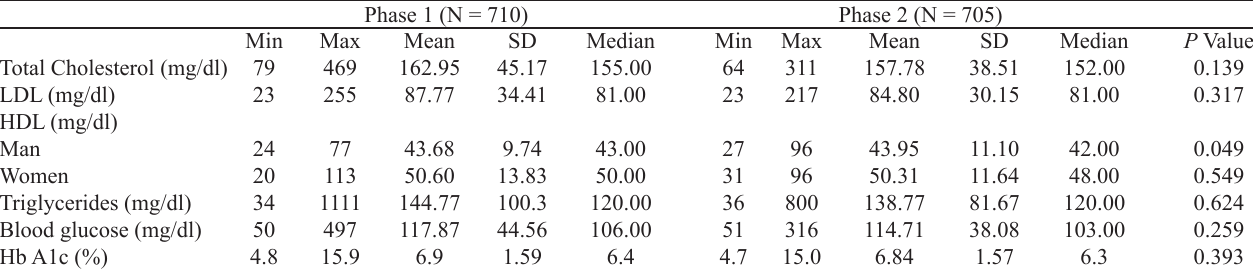
Table 4. Laboratory